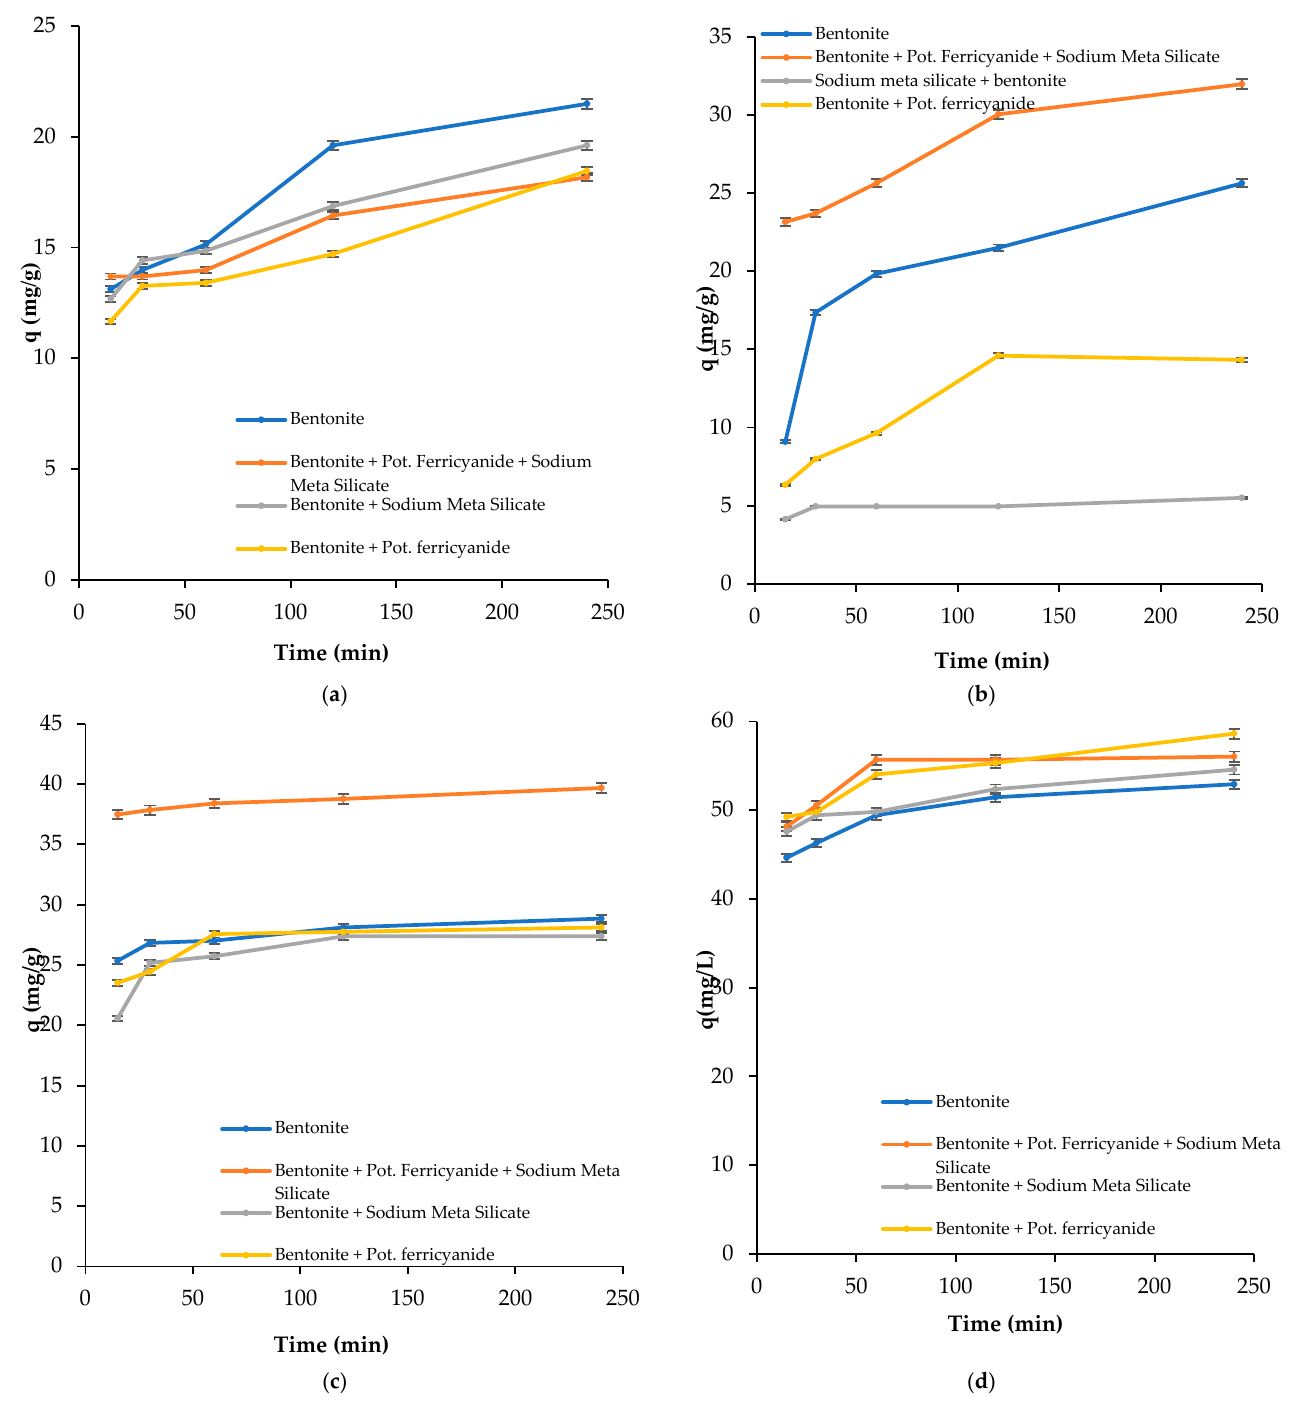
Figure 4. Adsorption capacities of adsorbents for ( a ) Acid red dye, ( b ) Direct violet-51, ( c ) Reactive red, and ( d ) Reactive green-5 dyes at varying contact times keeping the temperature 70 °C.